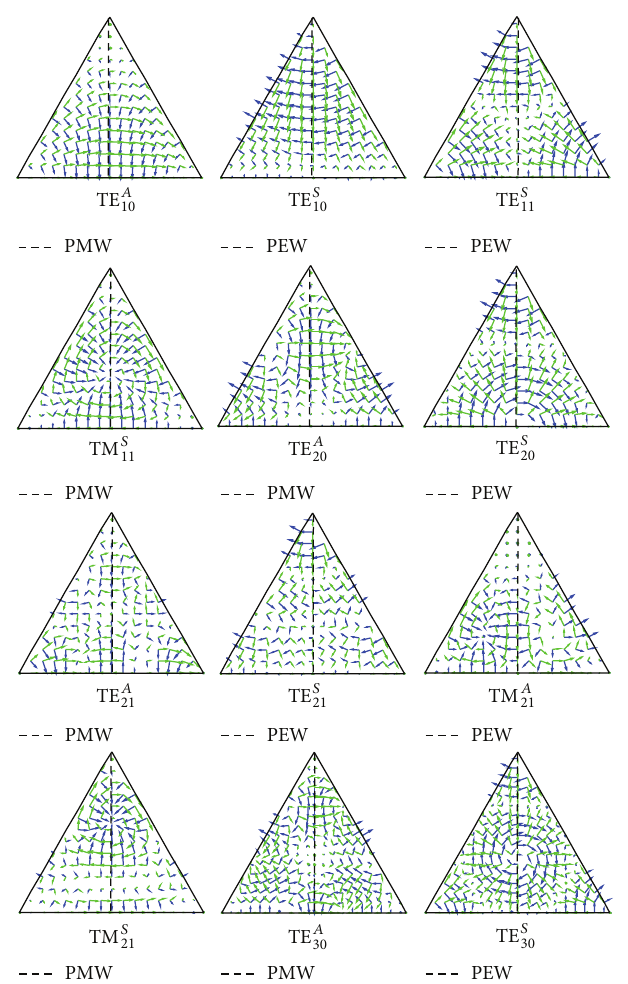
Figure2:Electricandmagneticfieldpattern(inblueandgreenarrows,resp.)forthefirsttwelvemodesintheequilateraltriangularwaveguide.